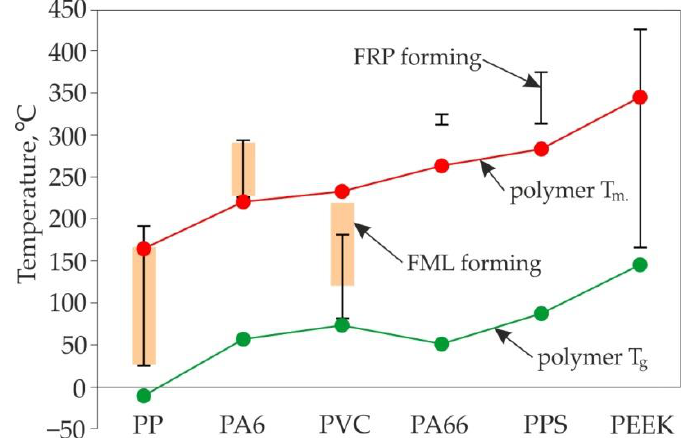
Figure 14. Forming temperature windows of FMLs, prepared on the basis of [109].